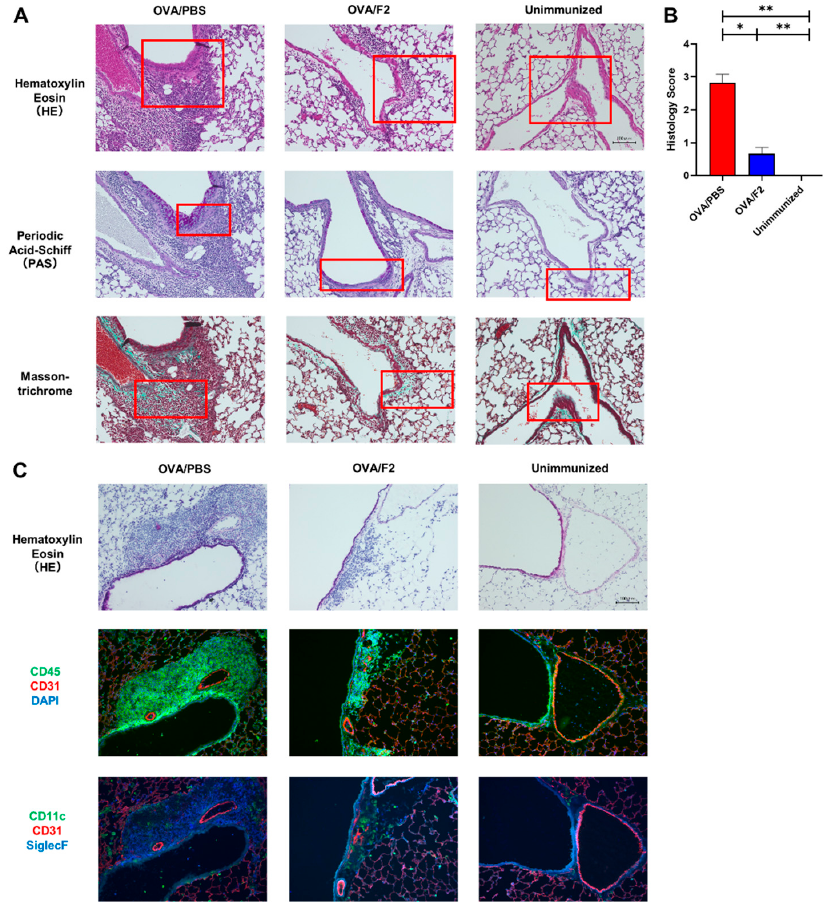
Figure 3. Decreased eosinophil infiltration and relieved allergic symptoms in mAb F2-administered mice. ( A ) Representative images are shown. Three different staining protocols were used to examine the leukocyte infiltration (H&E, upper), airway mucin production (PAS, middle), and airway fibrosis (MT, bottom). In the H&E staining, the cell nuclei are stained with blue, while the airway tract is stained with pink. In the PAS staining, the cell nuclei are stained with blue, while the polysaccharides of the mucin are stained with purple. In the MT staining, the collagen in the airway fibrosis is stained with green. Representative areas are marked with red. Scale bar, 100 μ m. ( B ) The histology score of lungs were determined by the severity of leukocyte infiltration. Each group contained 3–4 mice. At least three areas in each section were evaluated. ( C ) Immunofluorescence was performed using different combinations of fluorescence-conjugated antibodies. After induction of asthma, a significant number of CD45 + leukocytes infiltrated around CD31 + blood vessels and most of the leukocytes infiltrated were Siglec-F + eosinophils (OVA/PBS). The leukocyte infiltration was significantly suppressed by F2 administration (OVA/F2). Scale bar, 100 µ m. * p < 0.05, ** p < 0.01. A p -value of less than 0.05 was considered